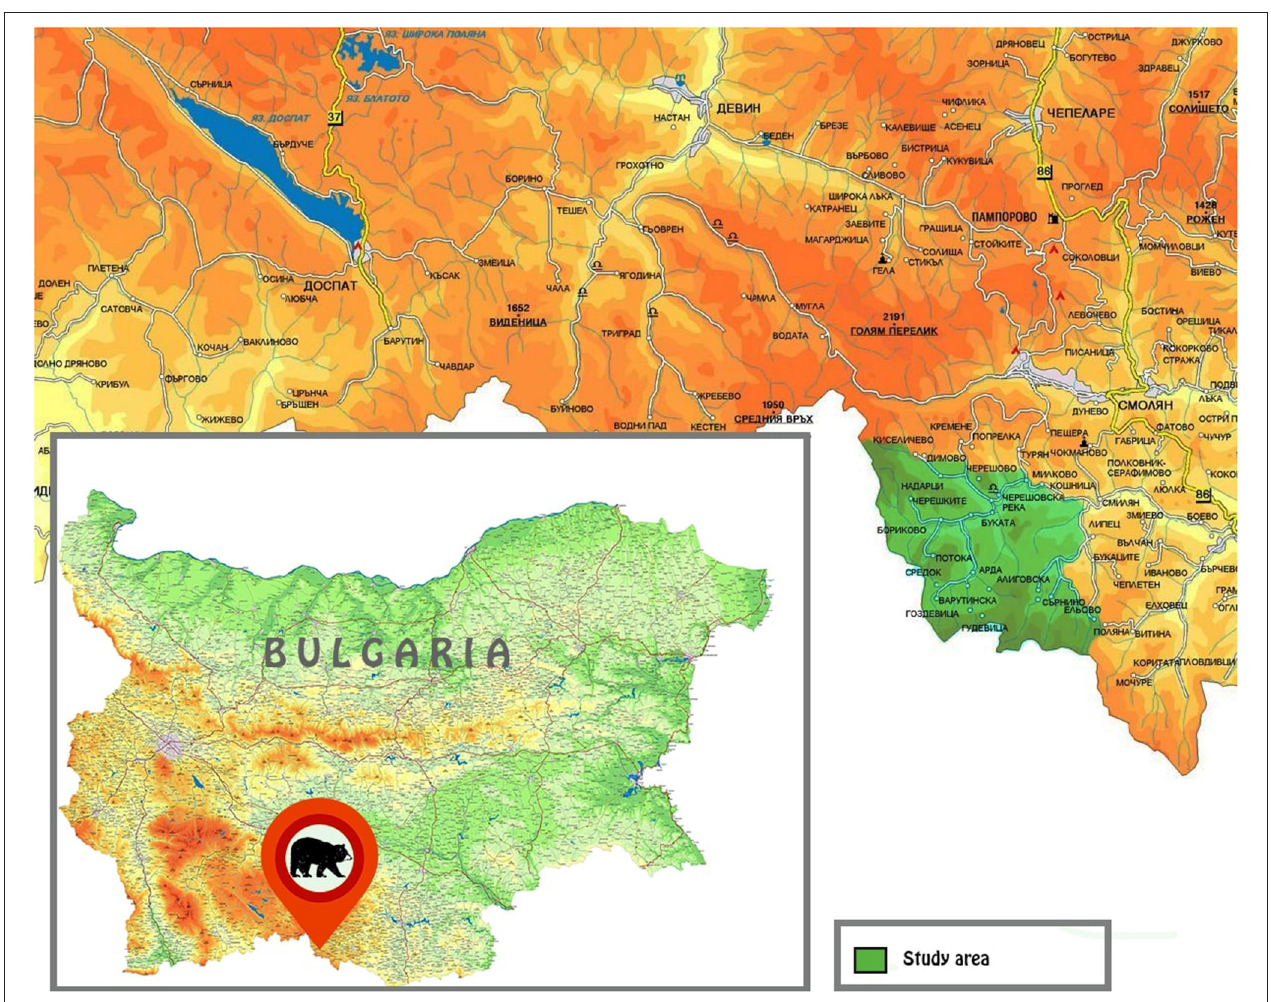
FIGURE 1 | Map of study